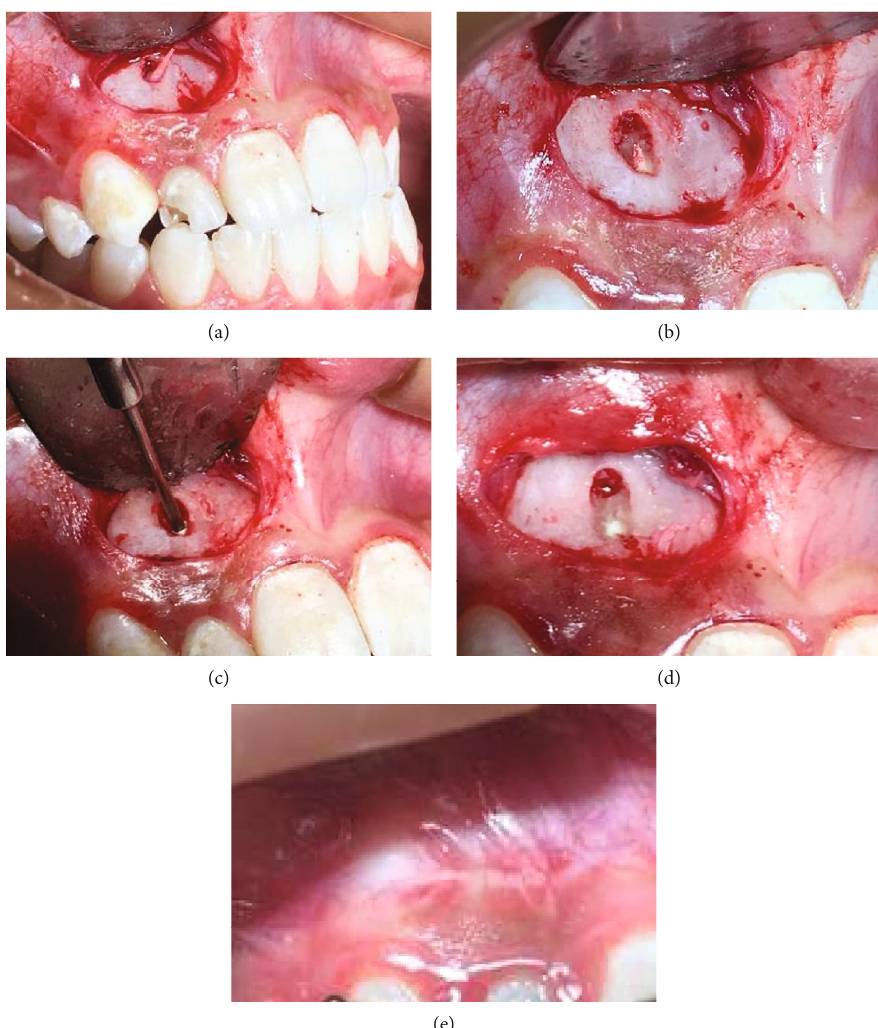
Figure 4: (a – e) Surgical procedure for removal of extruded gutta-percha and sealing with MTA; one year after the surgery, showing the gingival tissue in the buccal area, with normal